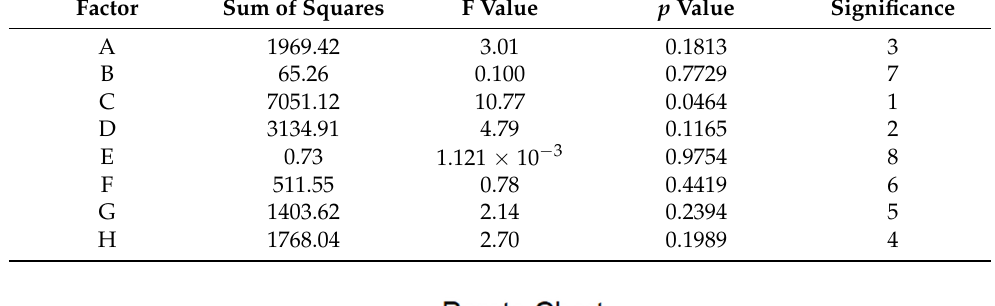
Table 9. Significant analysis of factors in the Plackett–Burman test.